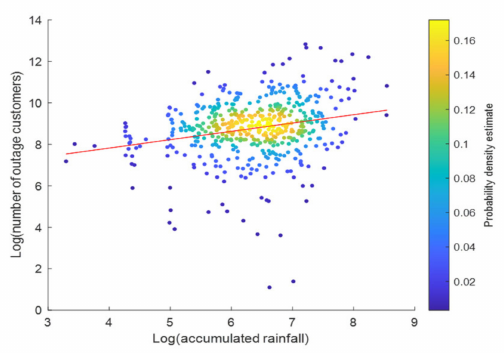
Figure 2. Average accumulated rainfall vs. number of outage customers.